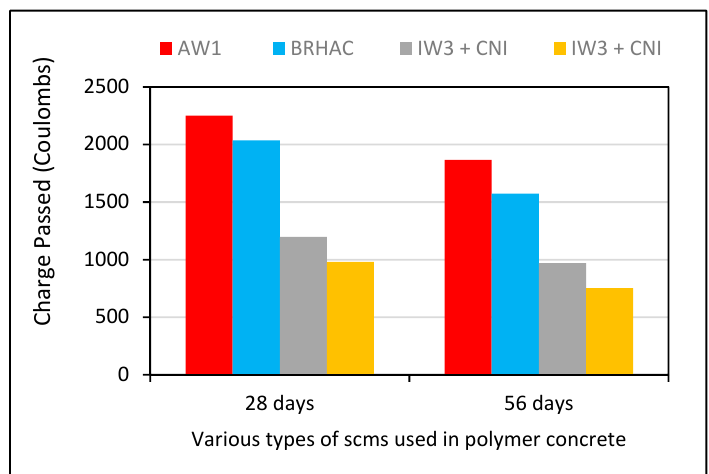
Figure 20. Chloride penetration at various curing ages for different SCMs.